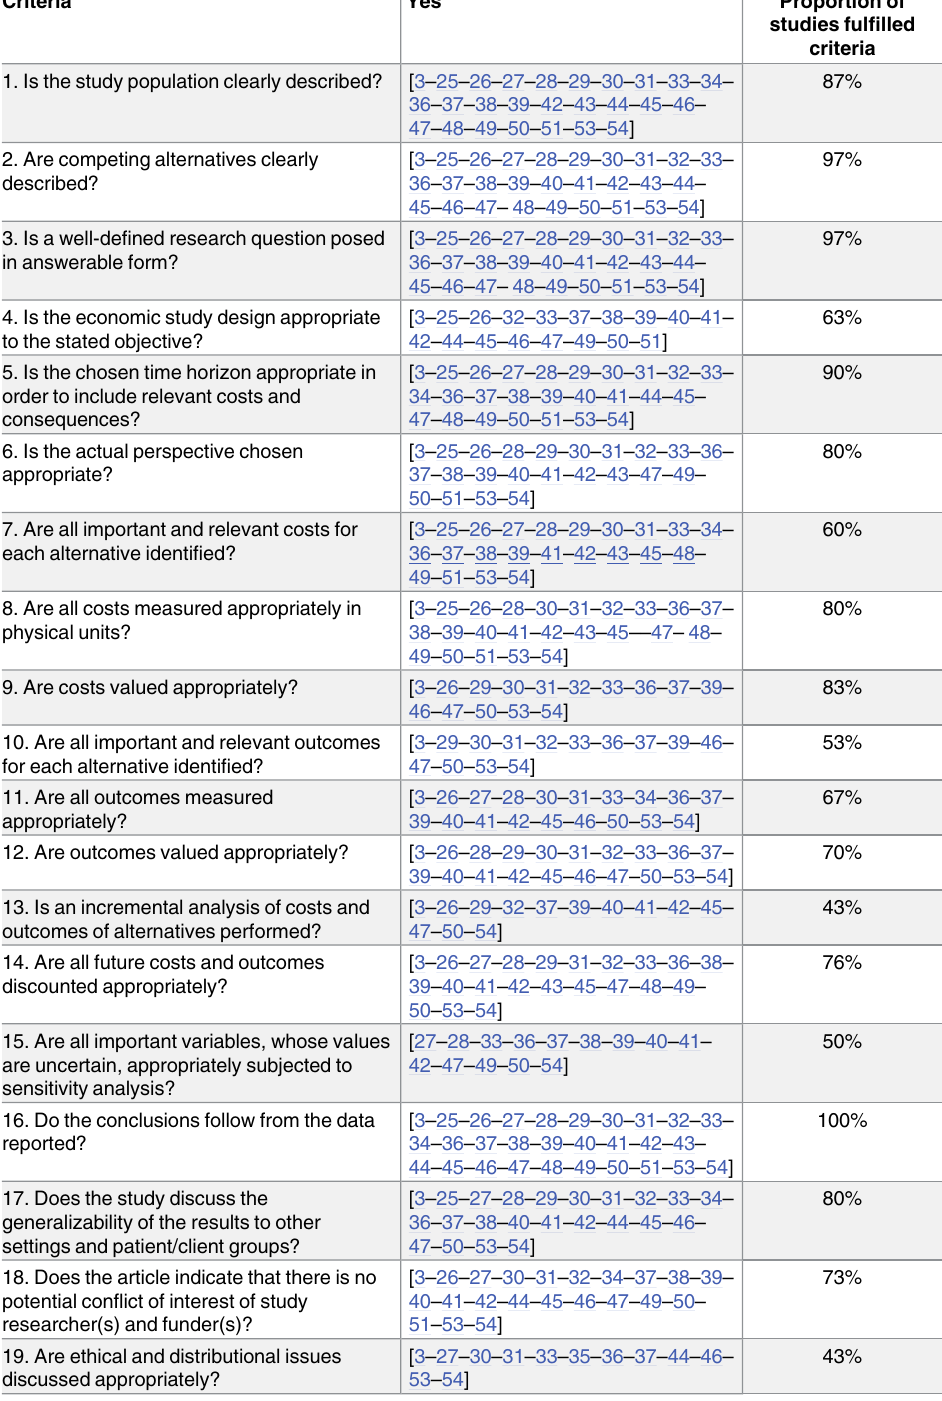
Table 2. Economic studies meeting the criteria for methodological quality on the CHEC-list (Evers, Goossens, de Vet, van Tulder, & Ament, 2005).